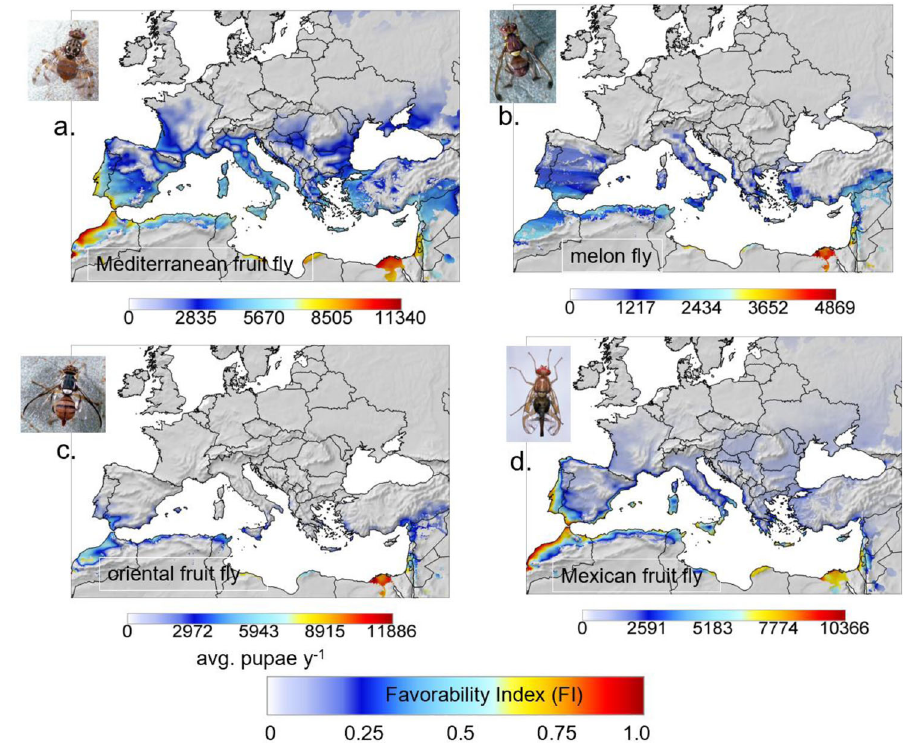
Fig. 3 Prospective average distribution and relative abundance (average annual sum of pupae) in the European-Mediterranean region during 1980 – 1990. a Mediterranean fruit fl y, b melon fl y, c oriental fruit fl y, and d Mexican fruit fl y (detailed maps in Supplementary Figs. S1, S2, S5, S6). Clips